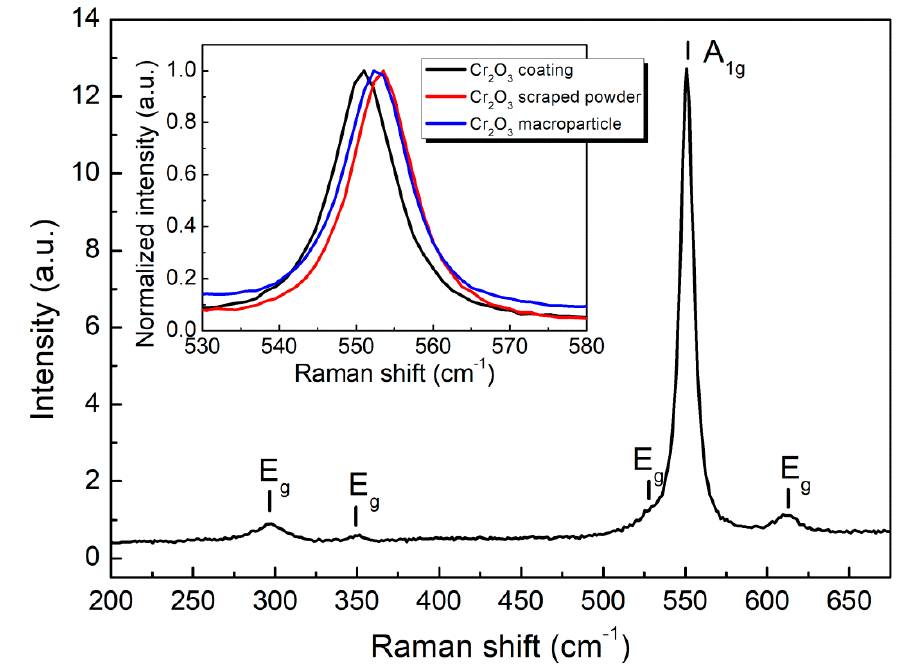
Figure 2. Raman spectrum of the Cr 2 O 3 coating. The inserts show amplified A 1g modes of the coating (black line), the scraped powder (red line) and Cr 2 O 3 macroparticles on the surface of the coating (blue line).